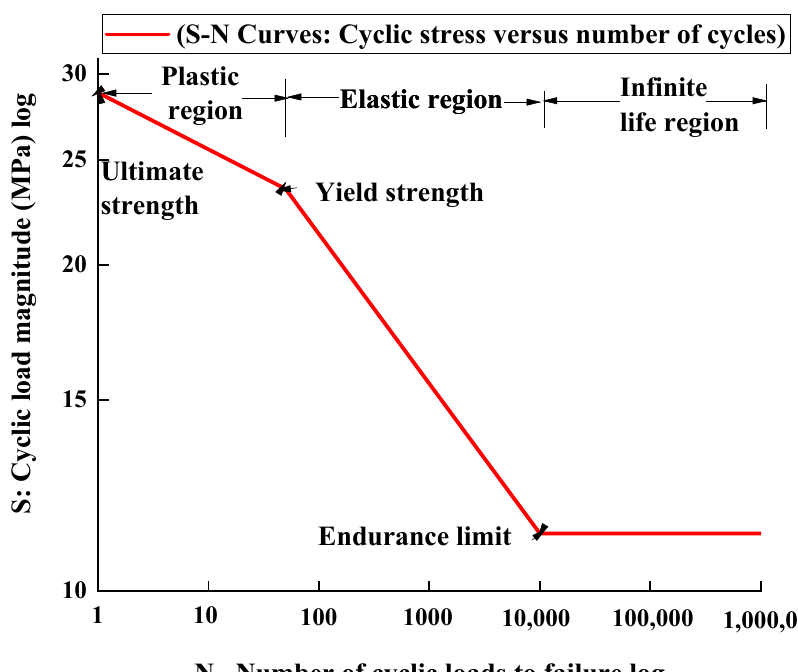
Figure 6. S - N curve of the fractured formation with a poro elasto plastic model coupling drill string vibration and loss circulation using the base case simulation parameters.